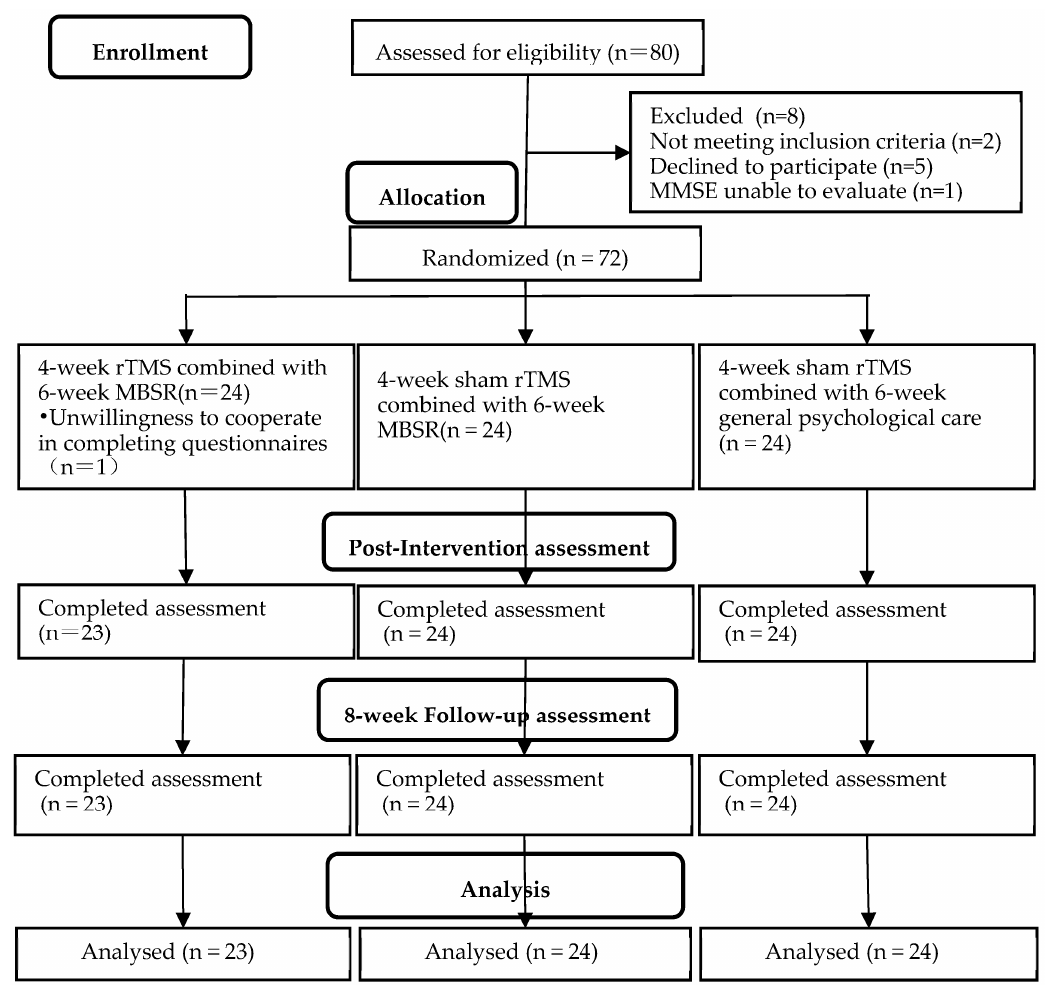
Figure 1. CONSORT flow diagram.